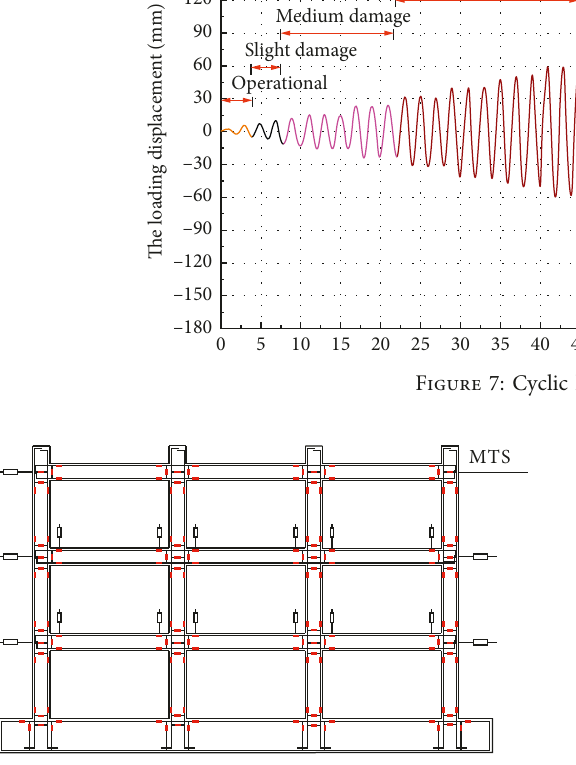
Figure 8: Traditional instruments. members and the displacement at each floor. Two wide- ranging LVDTs were placed at each floor level and one LVDTwas arranged at base beam level to monitor the lateral displacement. LVDTs with lower range were placed verti- cally at the ends of beams to obtain the beam-to-column relative rotation.